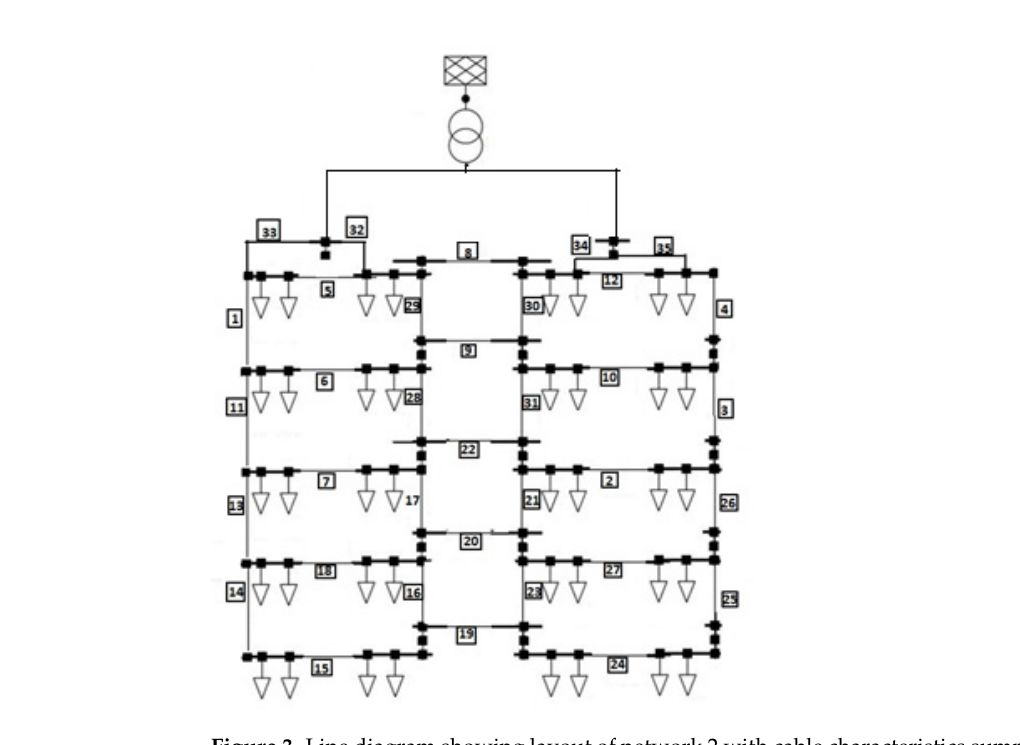
Figure 3. Line diagram showing layout of network 2 with cable characteristics summarized in Table 3. The network is uniform in terms of the rated sizes of the nodes, cable diameters, and lengths. Table 3. Cable characteristics of network 2.